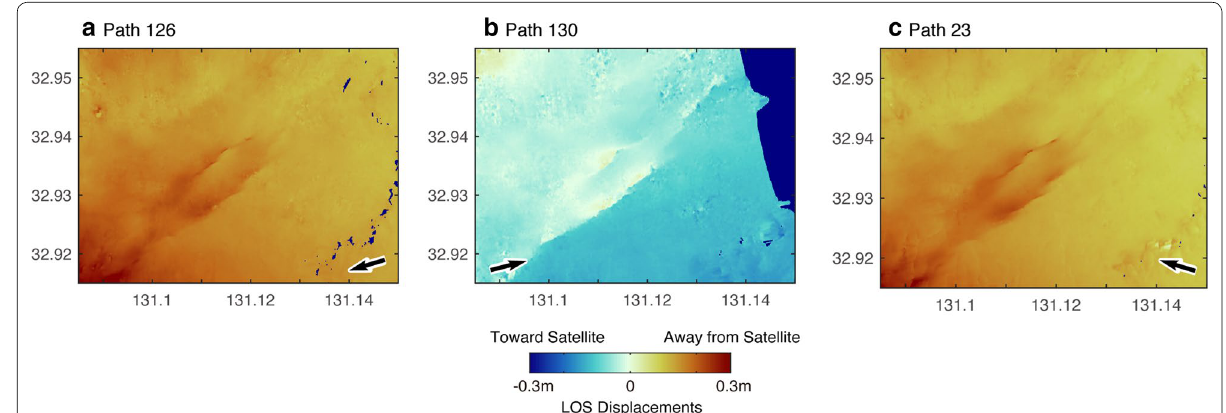
Fig. 3 Referenced and unwrapped LOS displacements obtained from three interferograms (Fig. 2d–f). a Path 126. b Path 130. c Path 23